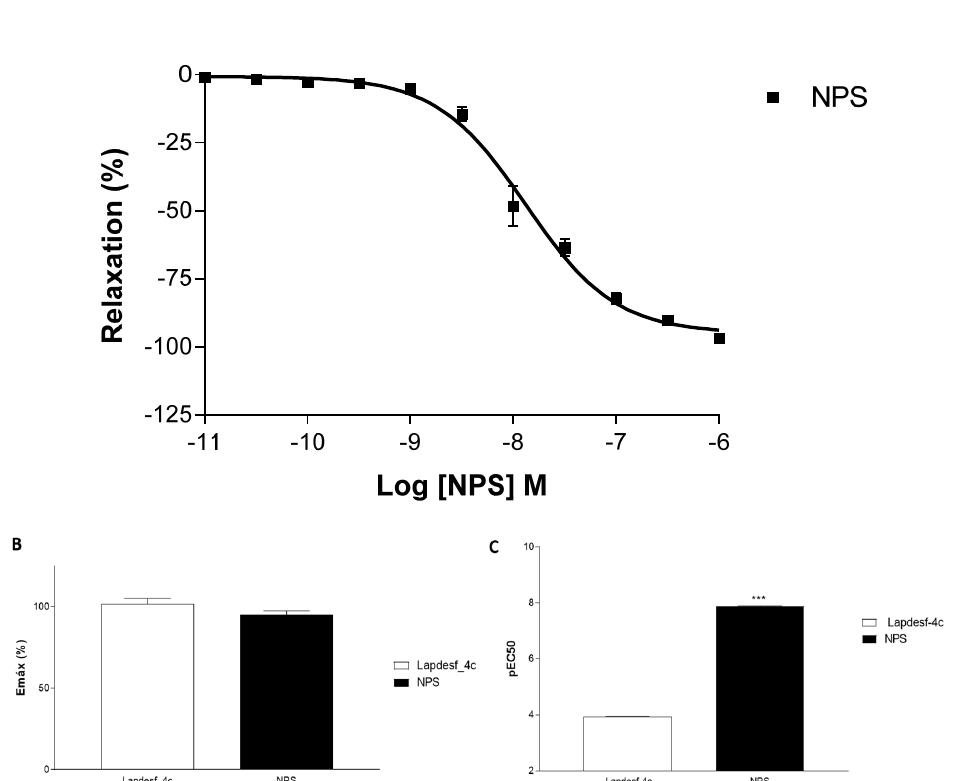
Figure 3. ( A ) Concentration–effect curves sodium nitroprusside (NPS) in the presence of the endothelium (E+). ( B ) shows the Emax values expressed in percentage for Lapdesf-4c (E+) and NPS (E+) without differences. ( C ) expresses the pEC50 values in the presence of the endothelium (E+) Lapdesf-4c and NPS *** p < 0.0001. Each experiment was performed on rings prepared from different rats.